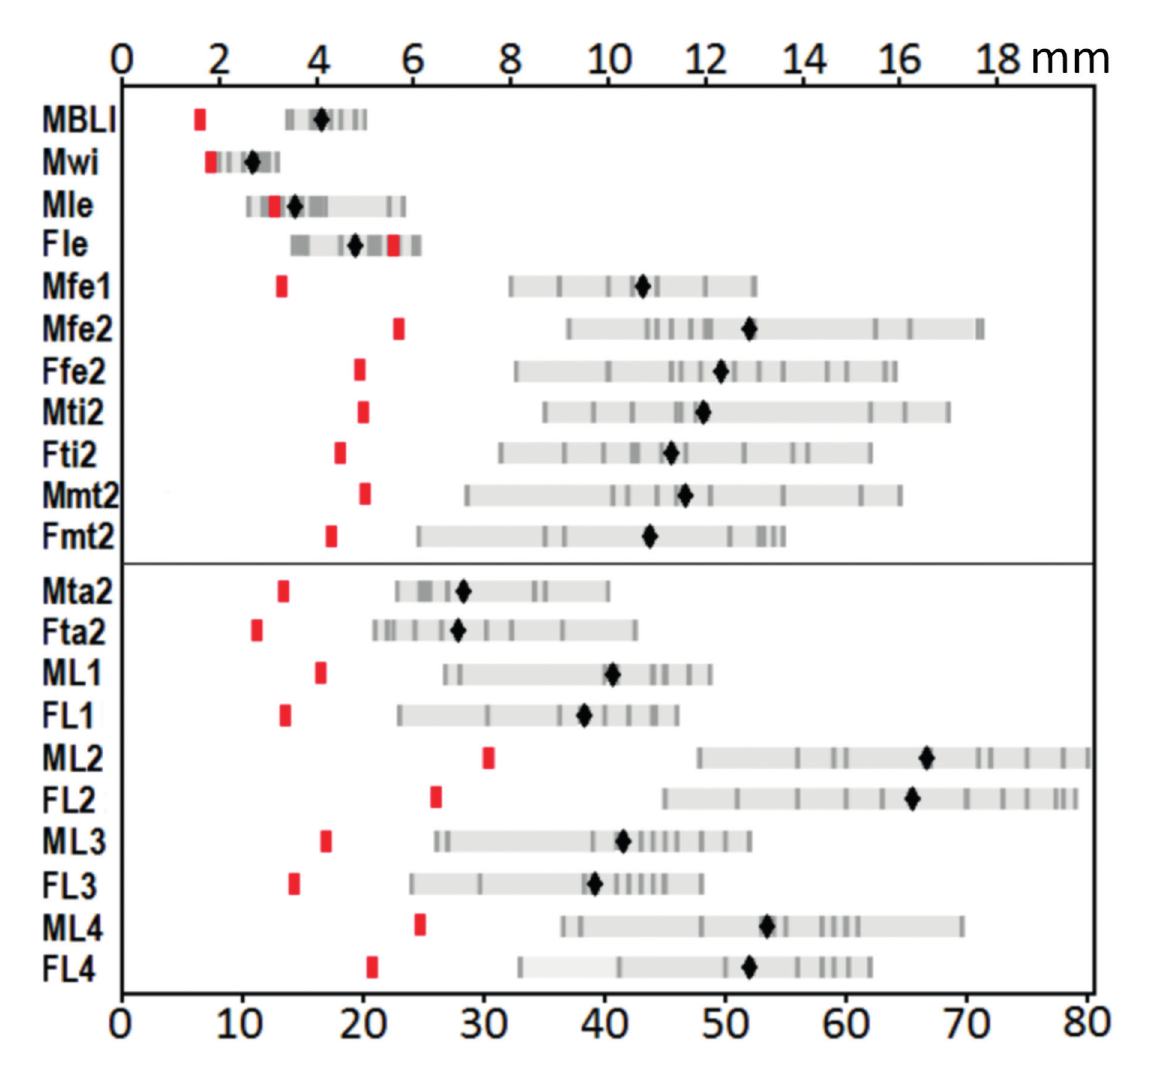
Fig. 9. Body size and leg length measurements (in mm apart from the MBLI ratio) of all European/ Mahgrebian species of Leiobunum C.L. Koch, 1839 (grey bars, diamonds on averages) and Leiolima iberica gen. et sp. nov. (red rectangles). Only the measured parameters for L. iberica gen. et sp. nov. are shown. Source of data: Caporiacco (1929), Karaman (1996), Komposch (1998), Martens (1978), Prieto & Fernández (2007), Prieto & Wijnhoven (2017) and Šilhavý